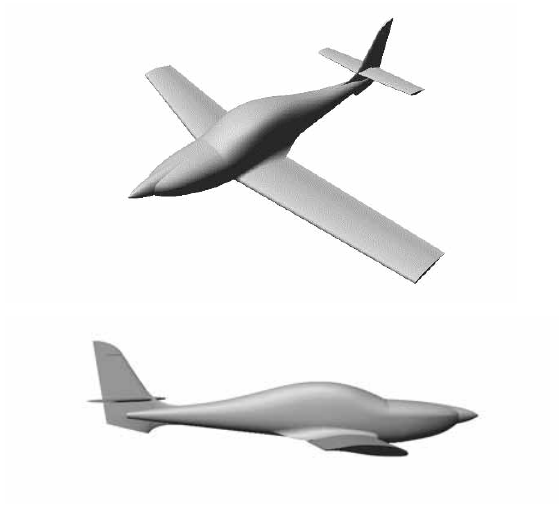
Fig. 2. The CFD model of a light aircraft